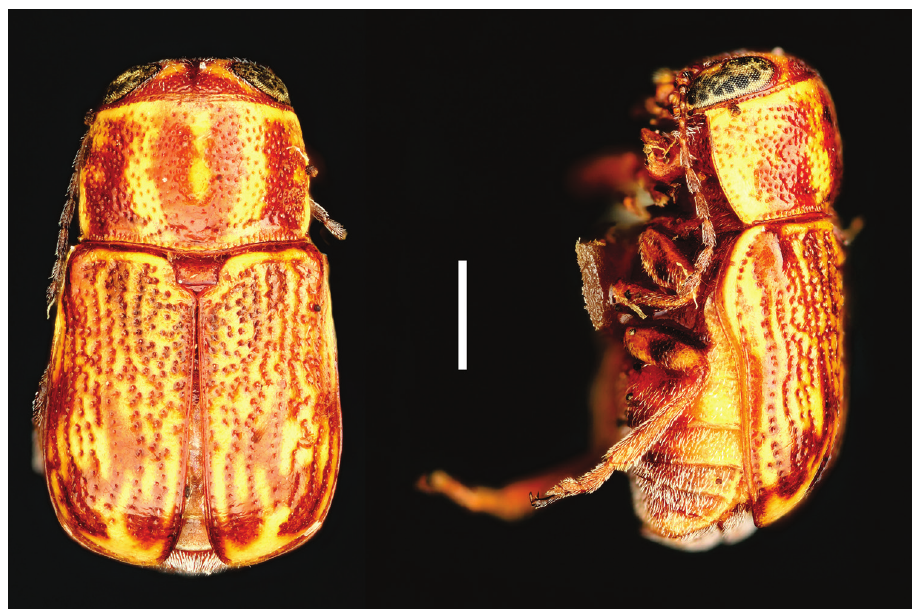
Figure 27. Pachybrachis mysticus Suffrian (2) , left: habitus (dorsal view), right: habitus (lateral view). Tribe Fulcidacini Jakobson, 1924 = Chlamisini Gressitt, 1946